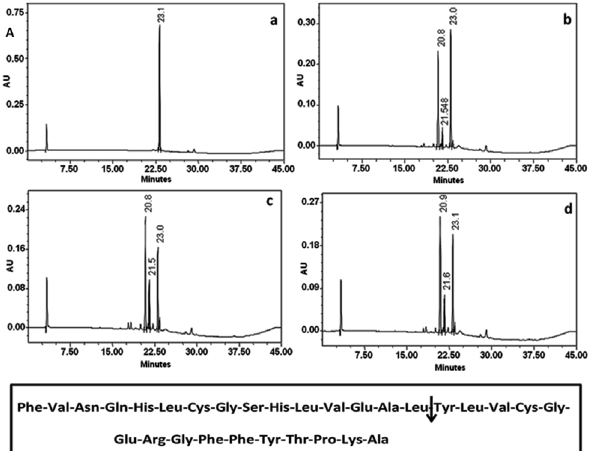
Fig 6. Hydrolytic specificity of cupincin on B-chain of insulin. (A). RP-HPLC profile showing the blank Insulin B chain (a). Cleavage pattern of B chain of insulin hydrolyzed by cupincin at 1hour (b), 2hours (b) and 3 hours (d) of incubation. The peptides were resolved using a Grace Vydac C-18 column (4.6 × 250mm). The solvents used were 0.1% Trifluoroacetic acid (TFA) and 70% acetonitrile containing 0.05% TFA. The peptides were detected at 230 nm. (B). Amino acid sequence of B-chain of insulin, arrow indicating the cleavage position of cupincin.